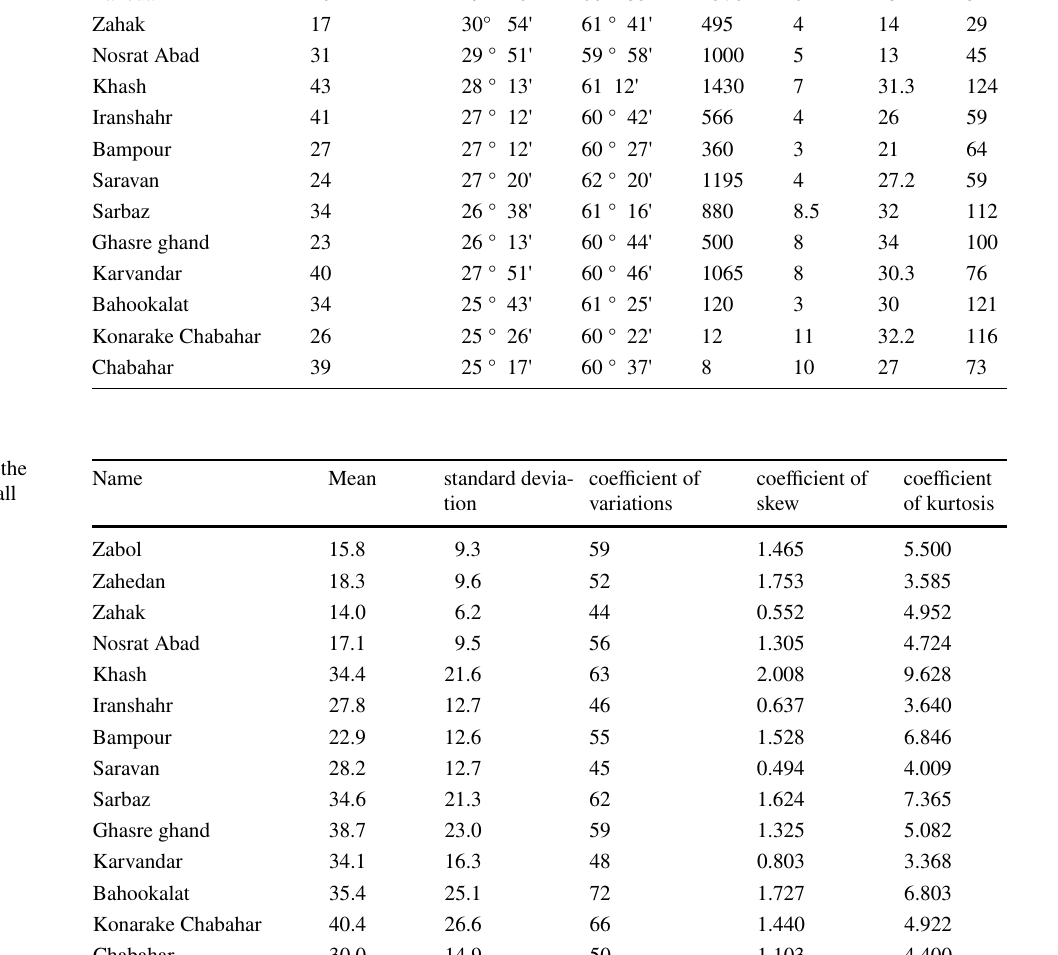
Table 1 Station’s name, sample size, geographical location, minimum, median and maximum daily rainfall